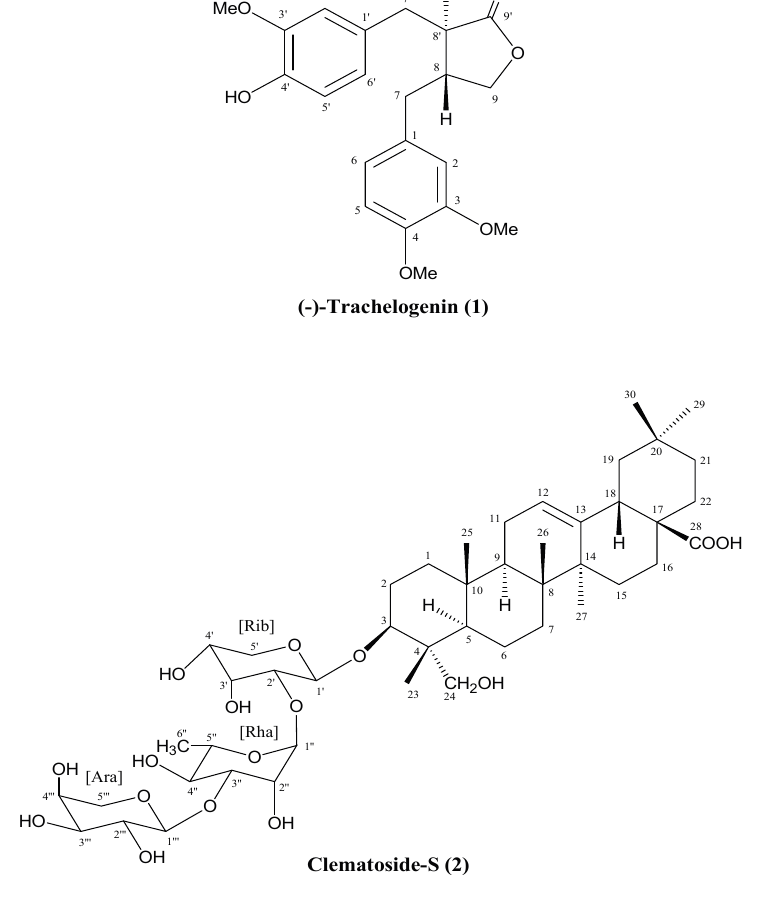
Figure 1. Chemical structure of ( − )-trachelogenin ( 1 ) and clematoside-S ( 2